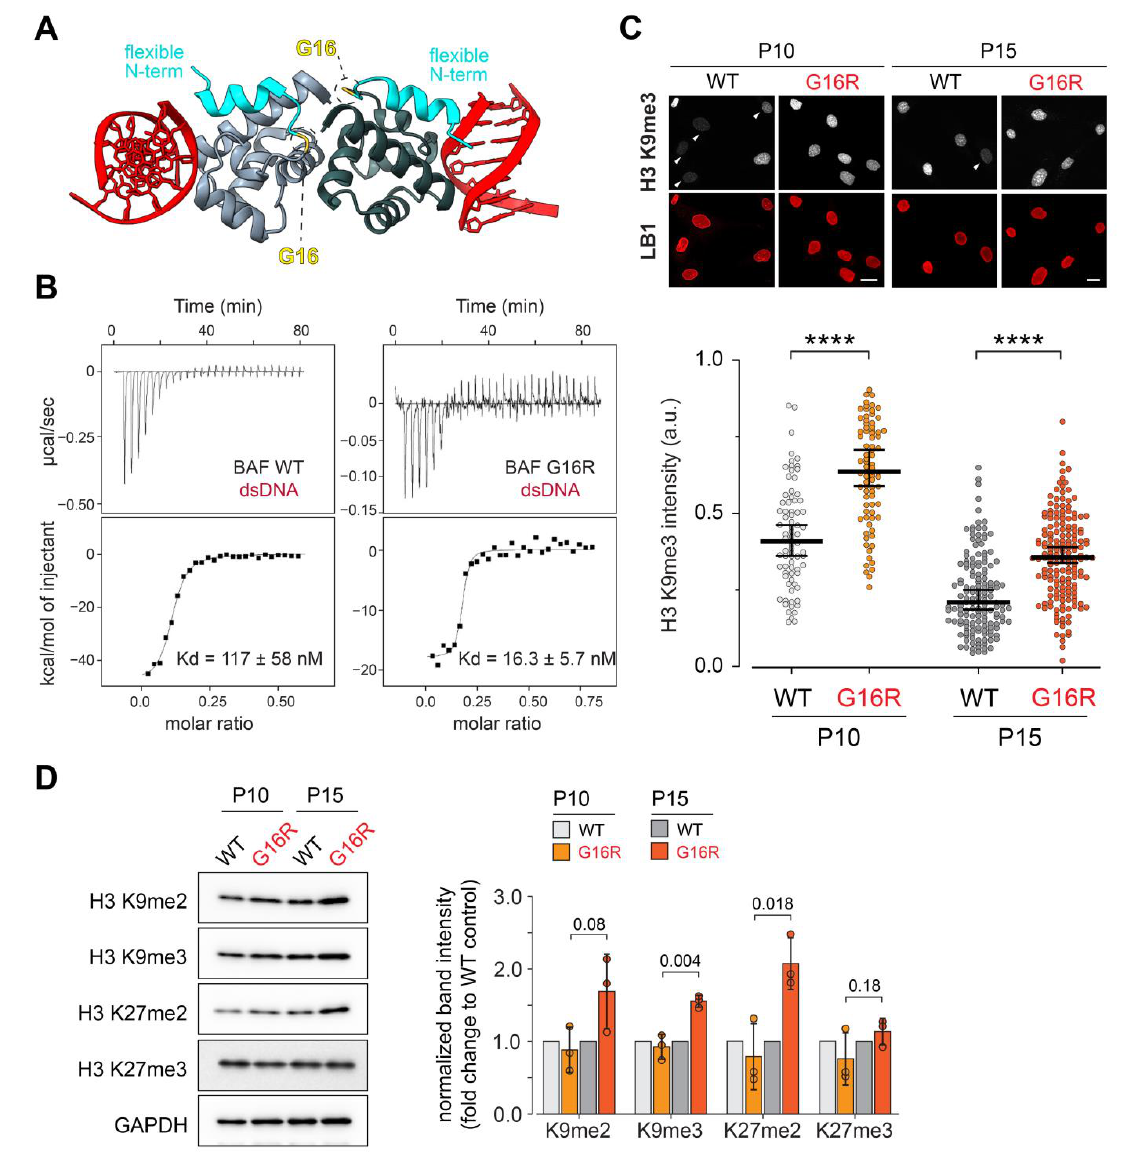
Figure 5. Enhanced DNA binding affinity of BAF Gly16Arg correlates with increased levels of repressed chromatin. ( A ) Cartoon of the crystal structure of the complex between the BAF dimer (light and dark grey) highlighting flexible N-terminal helix α 1 (cyan) and dsDNA (red). The position of the mutated Gly in each BAF monomer is indicated. The PDB reference of this 3D structure is 2BZF. ( B ) ITC titration analyses providing the affinity of BAF WT and Gly16Arg for a 22 nt-dsDNA. The experiment was repeated twice, and the dissociation constants represent the mean values calculated from these experiments (see Supplementary Figure S3). ( C ) Top : Confocal microscope images of control and patient passage 10 and 15 fibroblasts stained for histone H3K9me3 (white) and lamin B1 (LB1; red). Cells demonstrating low levels of H3K9me3 are indicated with arrowheads. Scale bars are 20 µ m. Bottom : Graphs of changes in H3K9me3 expression intensity at P10 and P15. Measurements were made on a minimum of 66 nuclei per passage, (n = 2) using CellProfiler software [41]. Means were compared using unpaired t -test (Graphpad Prism), **** = p < 0.0001. ( D ) Left : Western blot analyses of proteins extracted from passage 10 and 15 control and patient fibroblasts. Blots were probed with antibodies against indicated histone modifications. GAPDH served as a loading control. Right : Quantification of the Western blot signal intensity was normalized to GAPDH. Values are shown as fold change relative to wild-type control; n = 3, error bars indicate S.D.; Exact values for paired two-tailed t -test are